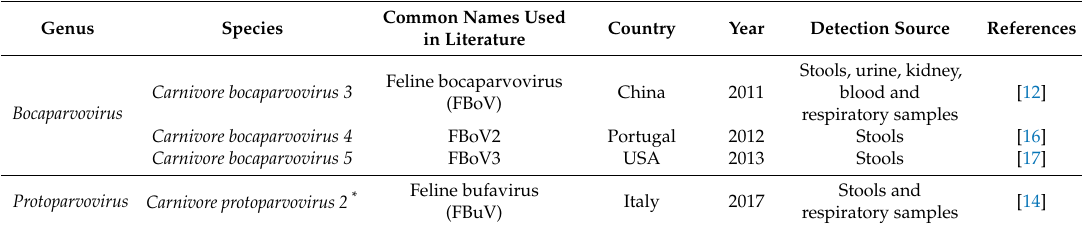
Table 4. Novel parvoviruses identified in cats and their current